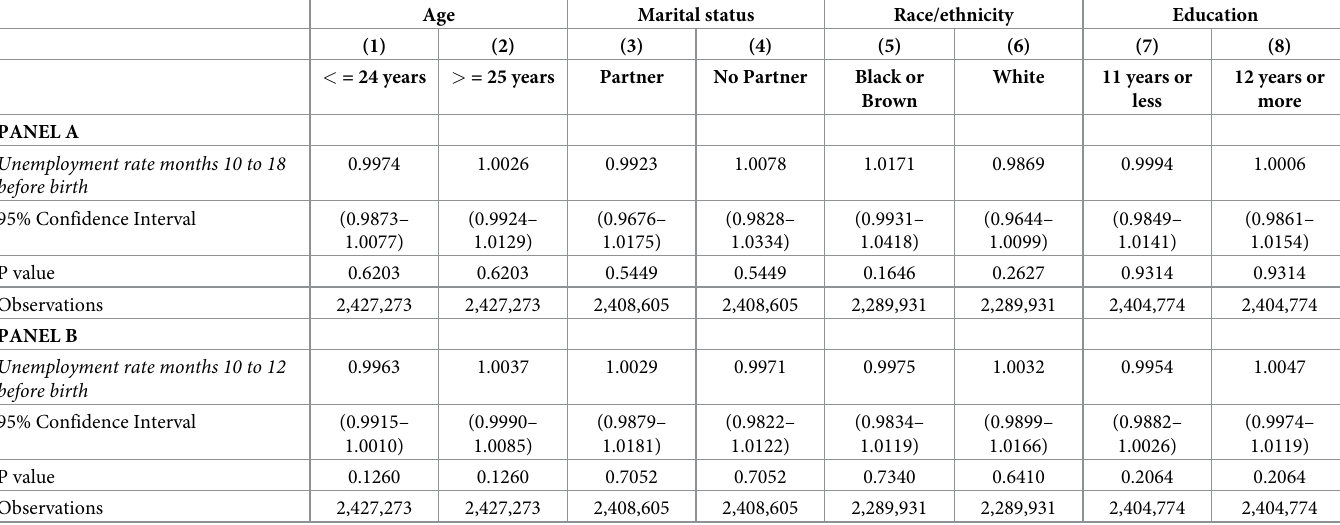
Table 5. Unemployment rate before conception and selection into motherhood.